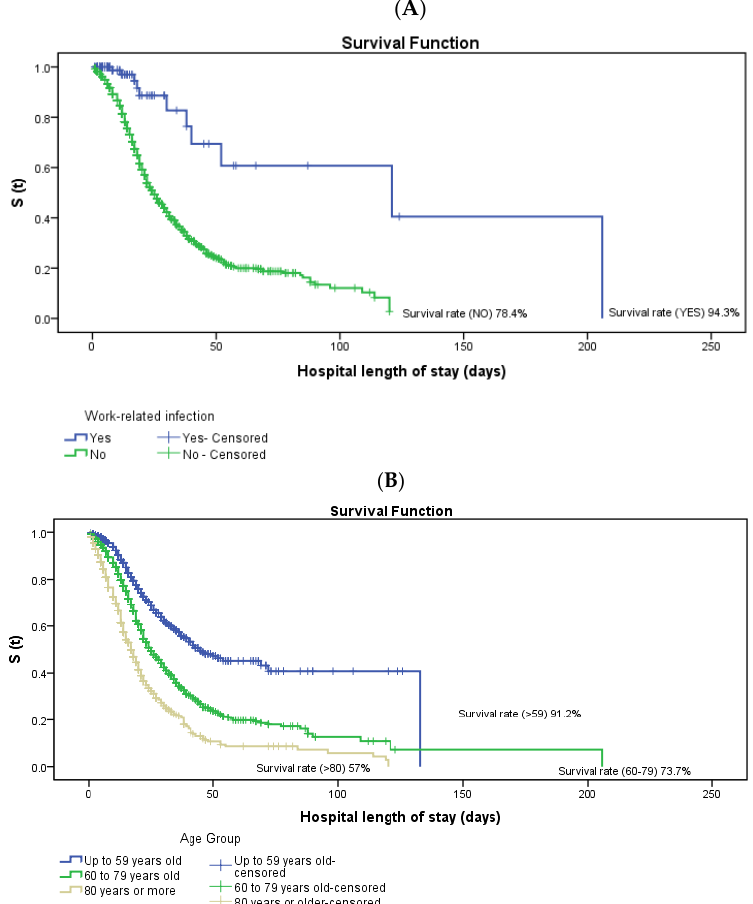
Figure 1. Survival curves of patients hospitalized with COVID-19 in Espírito Santo, Brazil. Log-rank test was used for comparison of equality of survival curves of sociodemographic variables in the period from 1 March 2020 to 31 July 2021. ( A ) Survival function according to the hospital length of stay of patients hospitalized with COVID-19 in Espírito Santo, Brazil, according to the independent variable work-related infection. ( B ) Survival function according to the hospital length of stay of patients hospitalized with COVID-19 in Espírito Santo, Brazil, according to the independent variable age group.